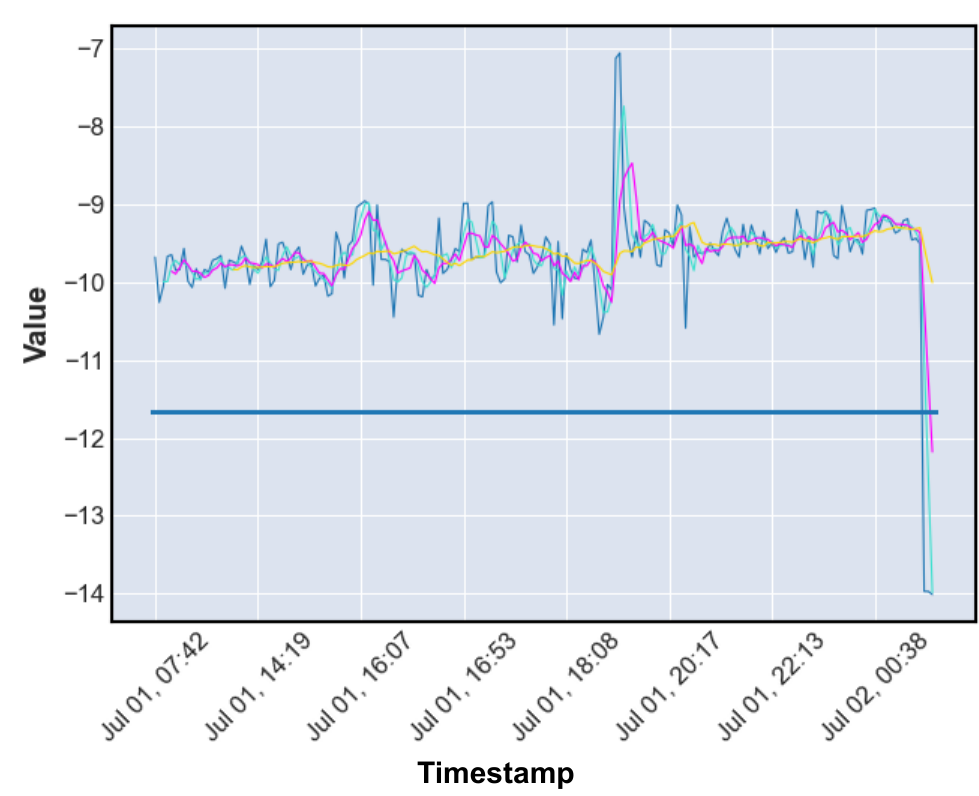
Figure 8. Monitoring graph for test Cell4_S22_1427_1520